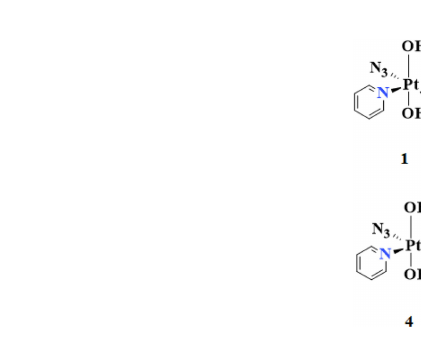
FIGURE 1 | The calculated chemical structures of compounds: trans , trans , trans -[Pt(N 3 ) 2 (OH) 2 (R 1 )(R 2 )][2(R 1 =2-picoline, R 2 =pyridine), 3(R 1 =3-picoline, R 2 =pyridine), 4(R 1 =4-picoline, R 2 =pyridine), 5(R 1 =3-picoline, R 2 =3-picoline) and 6(R 1 =4-picoline, R 2 =4-picoline)].